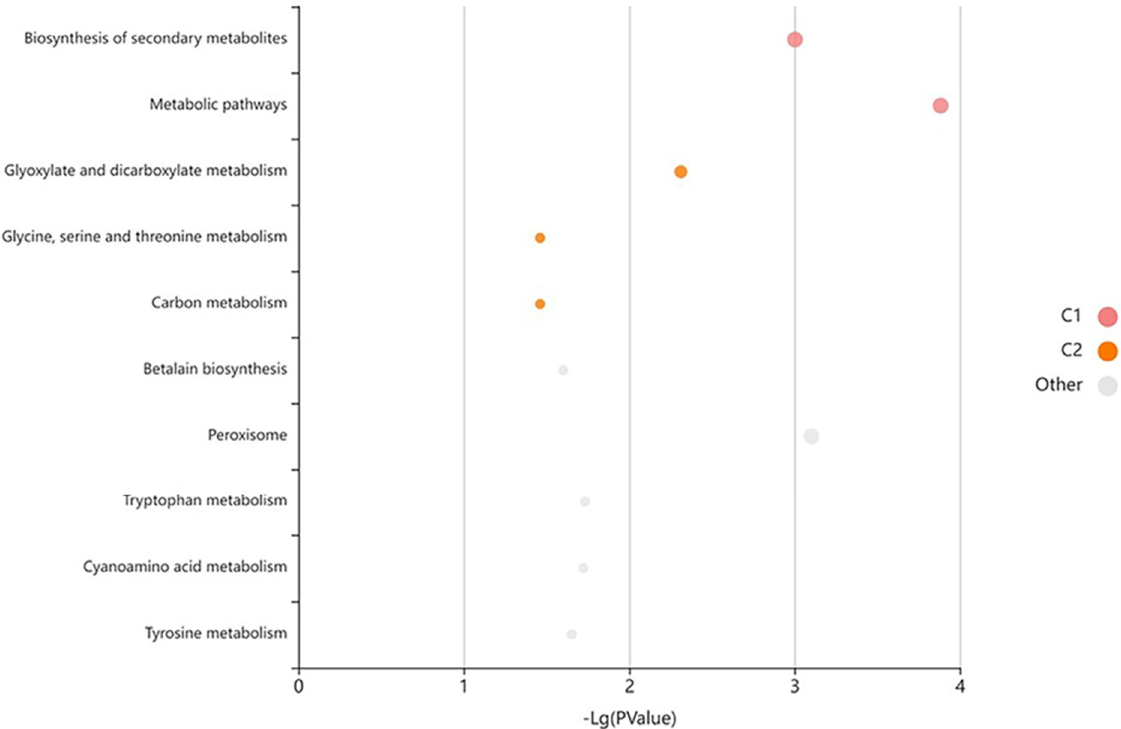
Figure 9. Bubble chart of the KOBAS enrichment analysis for co-expressed genes with SlPLATZ genes. Each bubble denotes an enriched function, and the sizes of the bubble from small to large reflect the following values: [0.05, 1], [0.01, 0.05], [0.001, 0.01], [0.0001, 0.001], [1 × 10 − 10 , 0.0001], [0, 1 × 10 − 10 ].